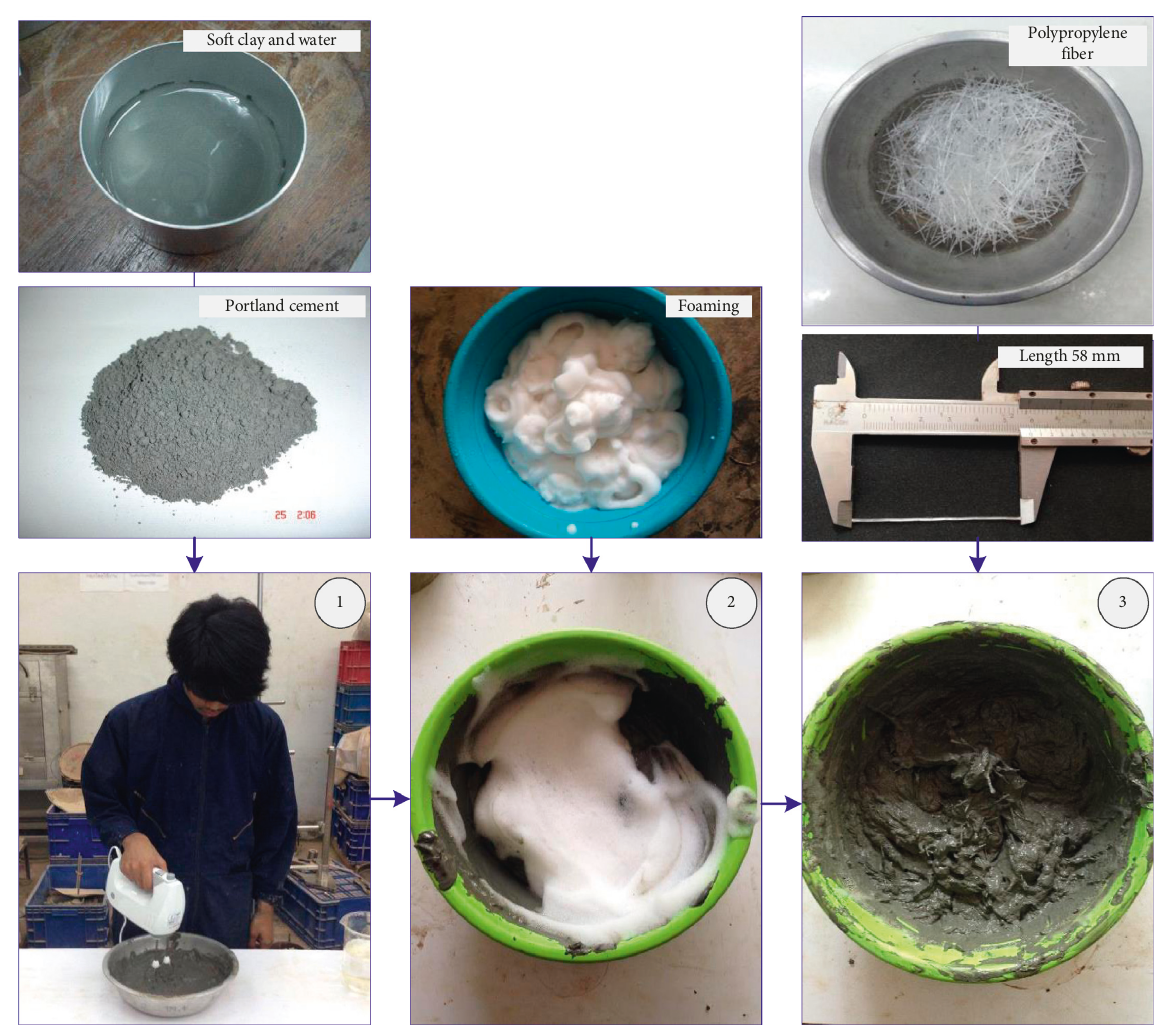
Figure 1: Schematic photographs of the mixing